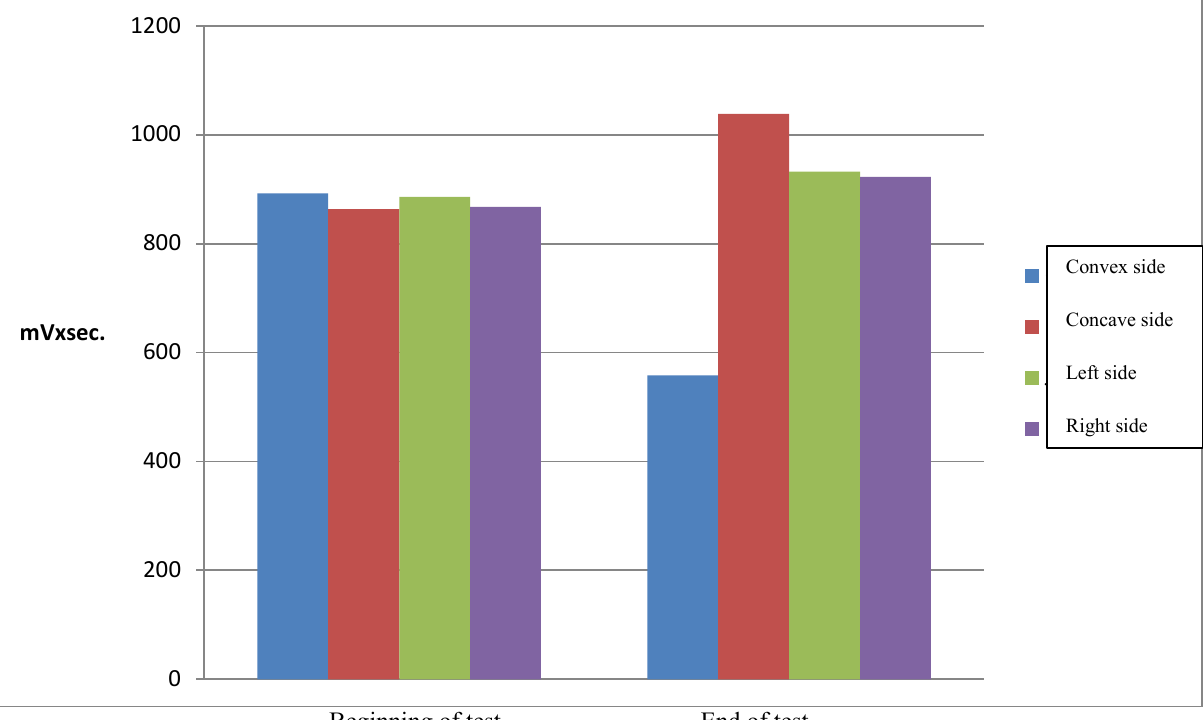
Fig.2. Indicators of back muscles’ electric activity in experimental and control groups during dynamic